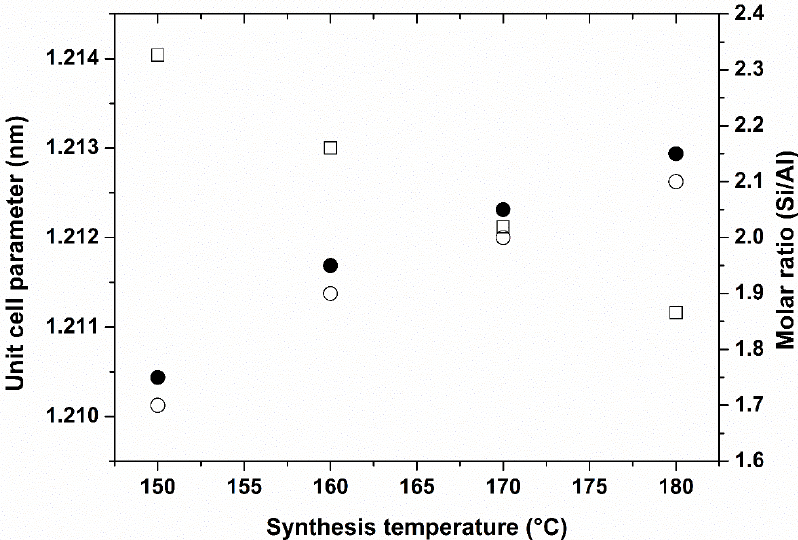
Figure 2. Evolution of the Si/Al molar ratio (full circles determined from XRF analysis and empty circles determined from 29 Si solid-state NMR) and the unit cell parameter (empty square; value determined from XRD refinement) of the ZK-4 zeolite framework depending on hydrothermal treatment temperature after 24 h.